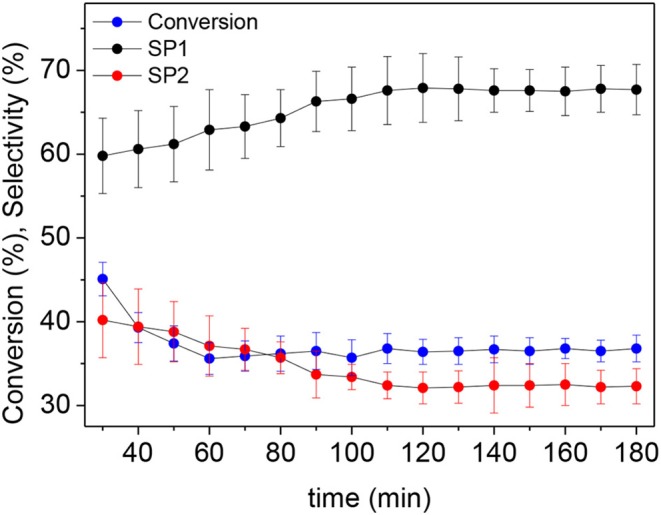
Catalytic performance of g-C3N4/Pt nanocatalyst during 180 min of reaction. Reaction conditions: 0.3 M levulinic acid solution in acetonitrile, 0.1 g of catalyst, T = 90 °C, P = 50 bar, Flow = 0.3 mL/min. SP1: selectivity to 1-ethyl-5-methylpyrrolidin-2-one, SP2: selectivity to 1-ethyl-2-(ethylideneamino)-5-methylpyrrolidin-2-ol.